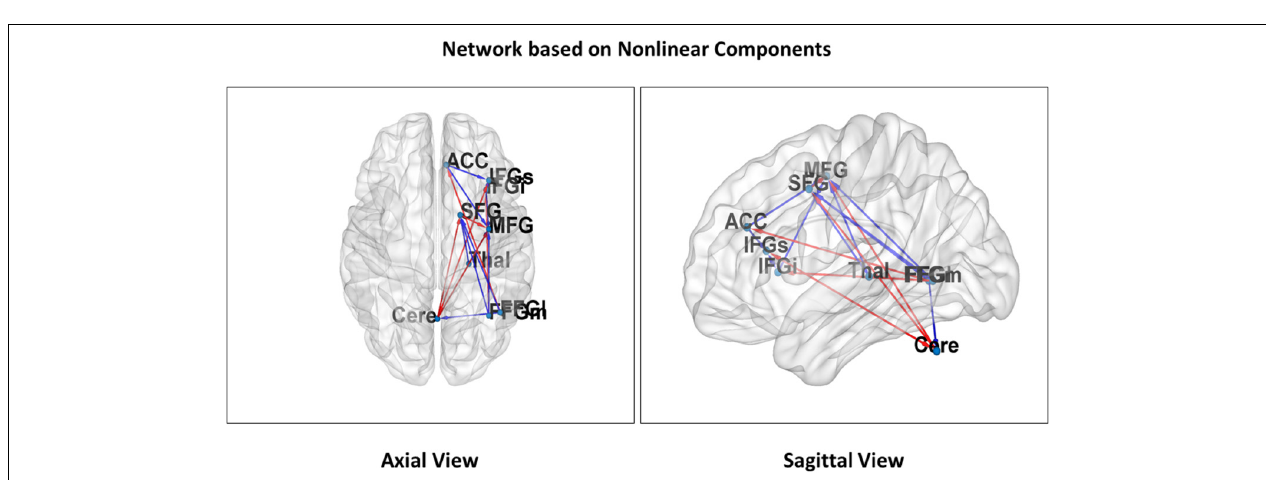
FIGURE 3 | Linear attentional networks. Nine regions of interest representing linear relationships in the executive centers of our attentional network are projected on both an axial (Left) and sagittal (Right) slice of the MNI reference (THAL, thalamus; SFG, superior frontal gyrus; IFGs, superior parts of the inferior frontal gyrus; IFGi, inferior parts of the inferior frontal gyrus; FFGl, lateral parts of the fusiform gyrus; FFGm, medial parts of the fusiform gyrus; CERE, Cerebellum; MFG, middle frontal gyrus; ACC, anterior cingulate cortex). The arrows visualize connections that showed a significant linear effect of the distraction parameter. Red arrows indicate a decrease and blue arrow an increase of connectivity with higher distraction. The hypothesized reduction of connectivity with increasing distraction is mainly found in frontal network areas whereas cerebellar connections show an increase. The latter finding may be due to increased motor-coordination as a result of increased stimulus/distraction-response events. In order to compare the intensity of activation over time, time-series data from nearest activation maxima in the normalized and smoothed functional images were extracted.